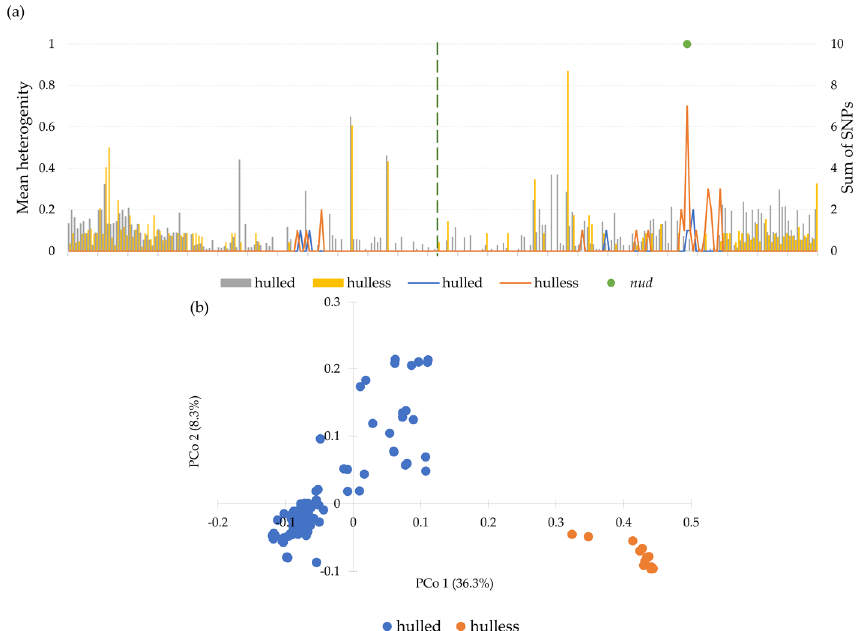
Figure 8. Genetic variation on the 7H chromosome for 116 spring barley landraces; ( a ) level of heterogeneity and unique SNPs assessed by a sliding window approach with 500 kb windows at 250 positions along the entire chromosome; ( b ) results of Principal Coordinate Analysis (PCoA) with indication the grain type.